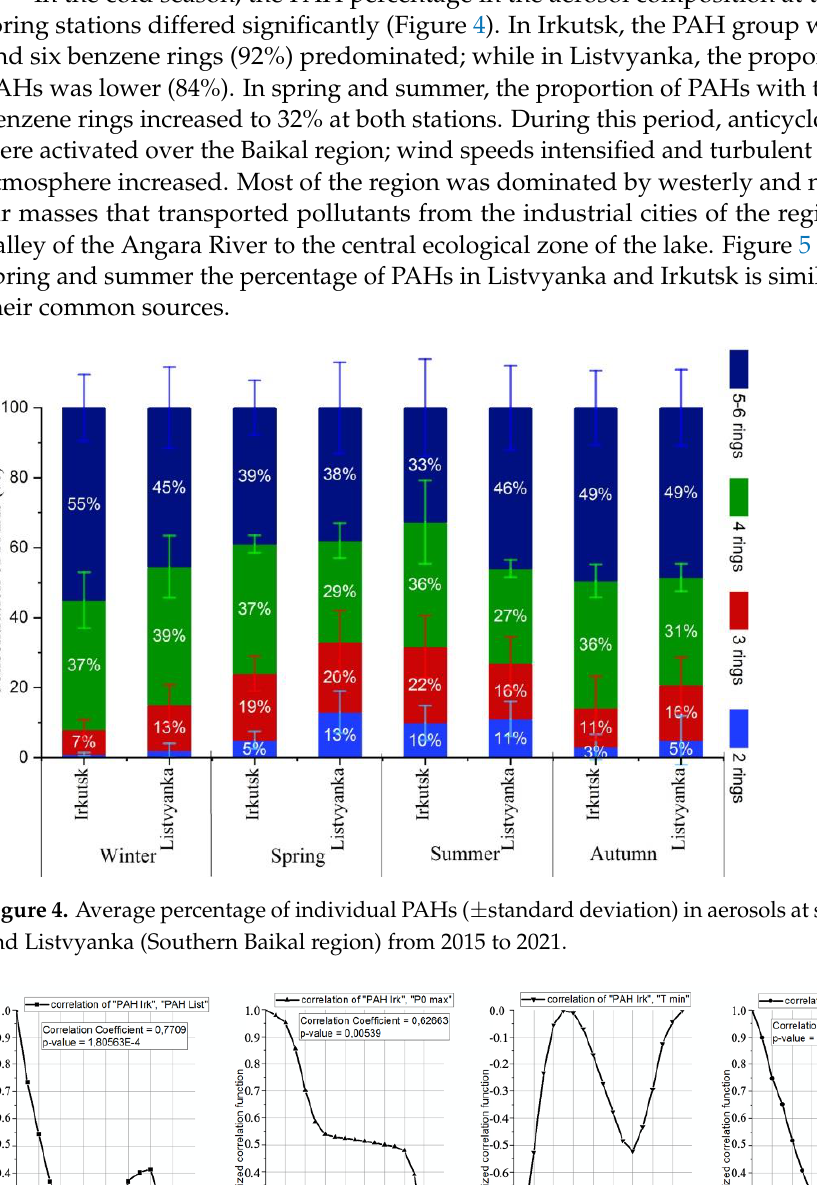
Figure 3. Average percentage of individual PAHs in aerosols at stations Irkutsk and Listvyanka (Southern Baikal region) from 2015 to 2021.